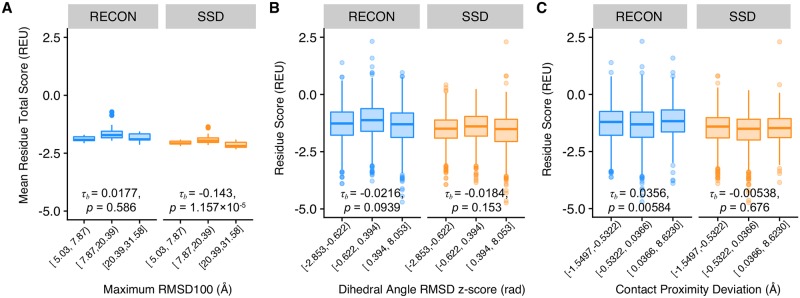
Comparison of conformational diversity and per-residue total scores.All panels are binned into low, medium, and high x values, with equal number of data points for each bin. A Kendall τβ rank correlation test was performed on each profile to measure the strength of dependence of native sequence recovery on the x axis value, indicated in each plot along with its associated p-value. (A) Comparison of maximum RMSD100 and mean total energy score, normalized by the number of residues. (B) Comparison of normalized RMSDda
z-score and mean total energy score of each residue. (C) Comparison of normalized contact proximity deviation z-score and mean total energy score of each residue.